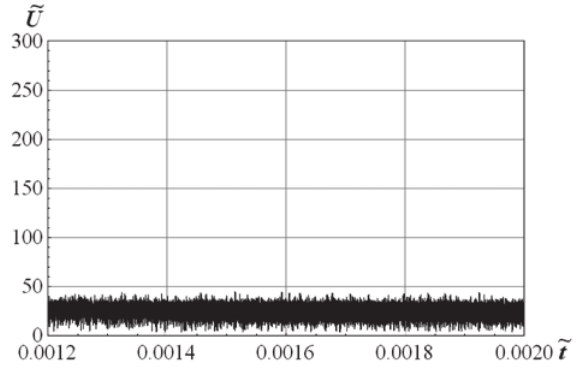
Fig. 2. A diagram of acoustic emission resultant signal amplitude variation over time in relative units during friction of composite material surface layers, according to (2). Simulation